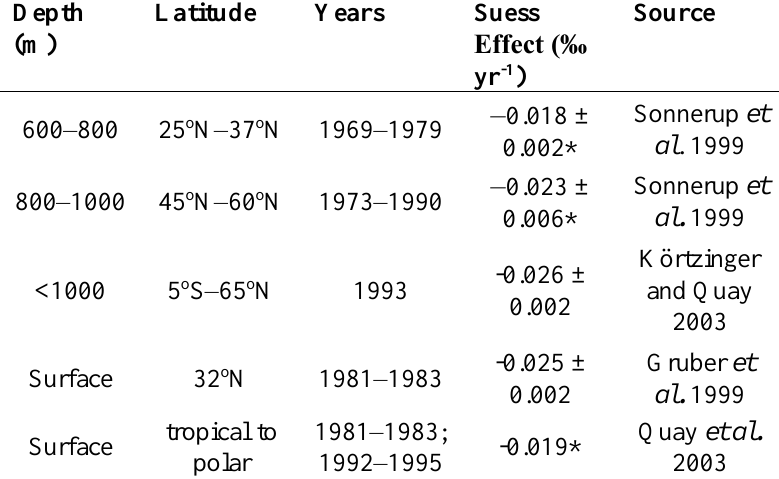
Table 2. Oceanic 13 C Suess effect rates for the North Atlantic Ocean basin spanning the timeframe represented by sampled killer whale and beluga GLGs. Estimates are restricted to depths < 1000